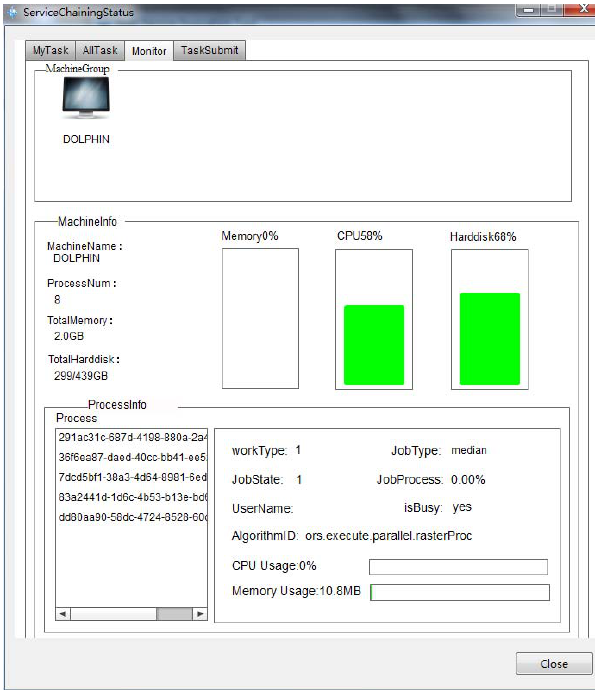
Figure 4. Server information